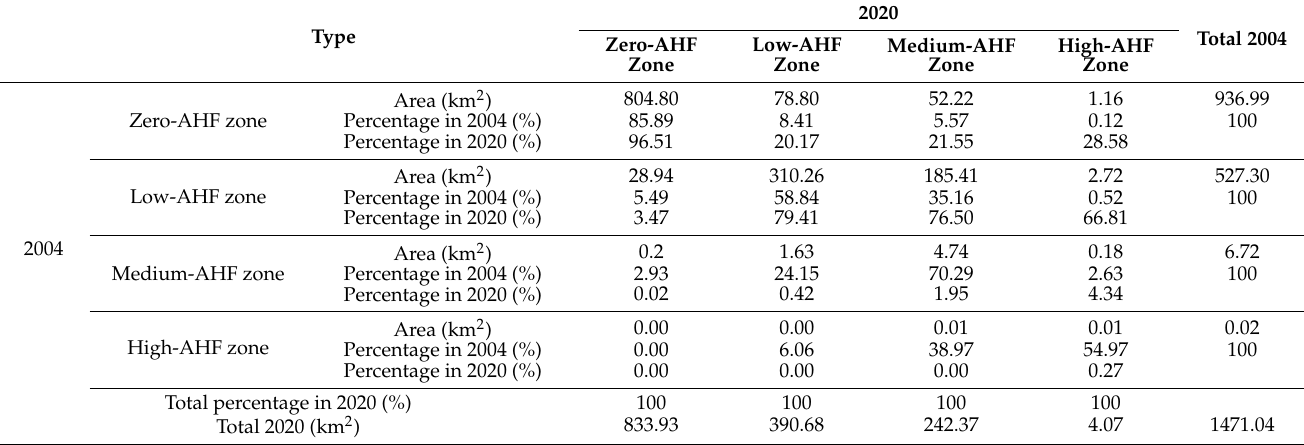
Table 7. Transfer matrix of different anthropogenic heat level types from 2004 to